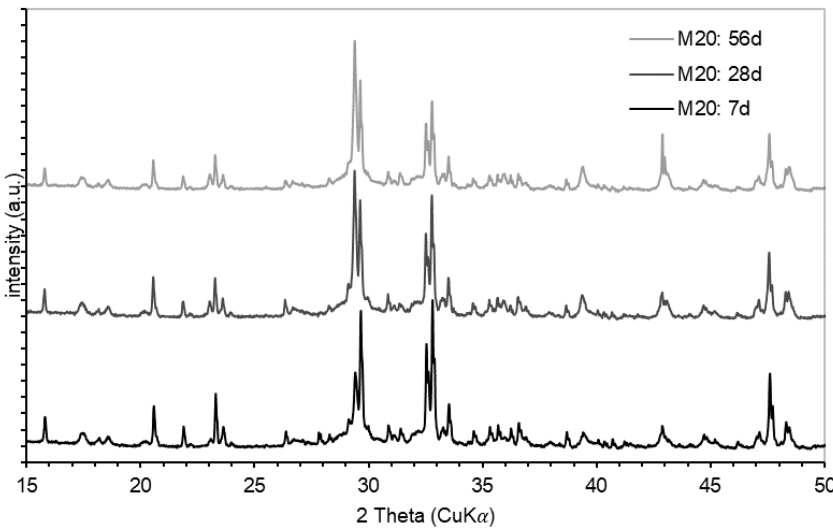
Figure 8. XRD patterns of alkali-activated slag at 20 °C and different curing times.